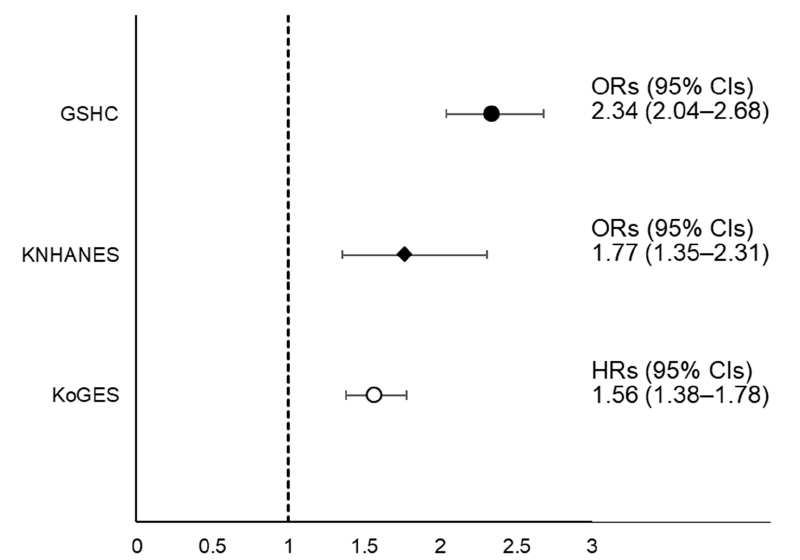
Figure 3. Forest plot of ORs or HRs with 95% CIs for NAFLD according to LSMI status. Abbrevia- tions: HRs, hazard ratios; ORs, odds ratios; CIs, confidence intervals; LSMI, low skeletal muscle mass index; NAFLD, non-alcoholic fatty liver disease; KNHANES, Korean National Health and Nutrition Examination Survey; KoGES, Korean Genome and Epidemiology Study.